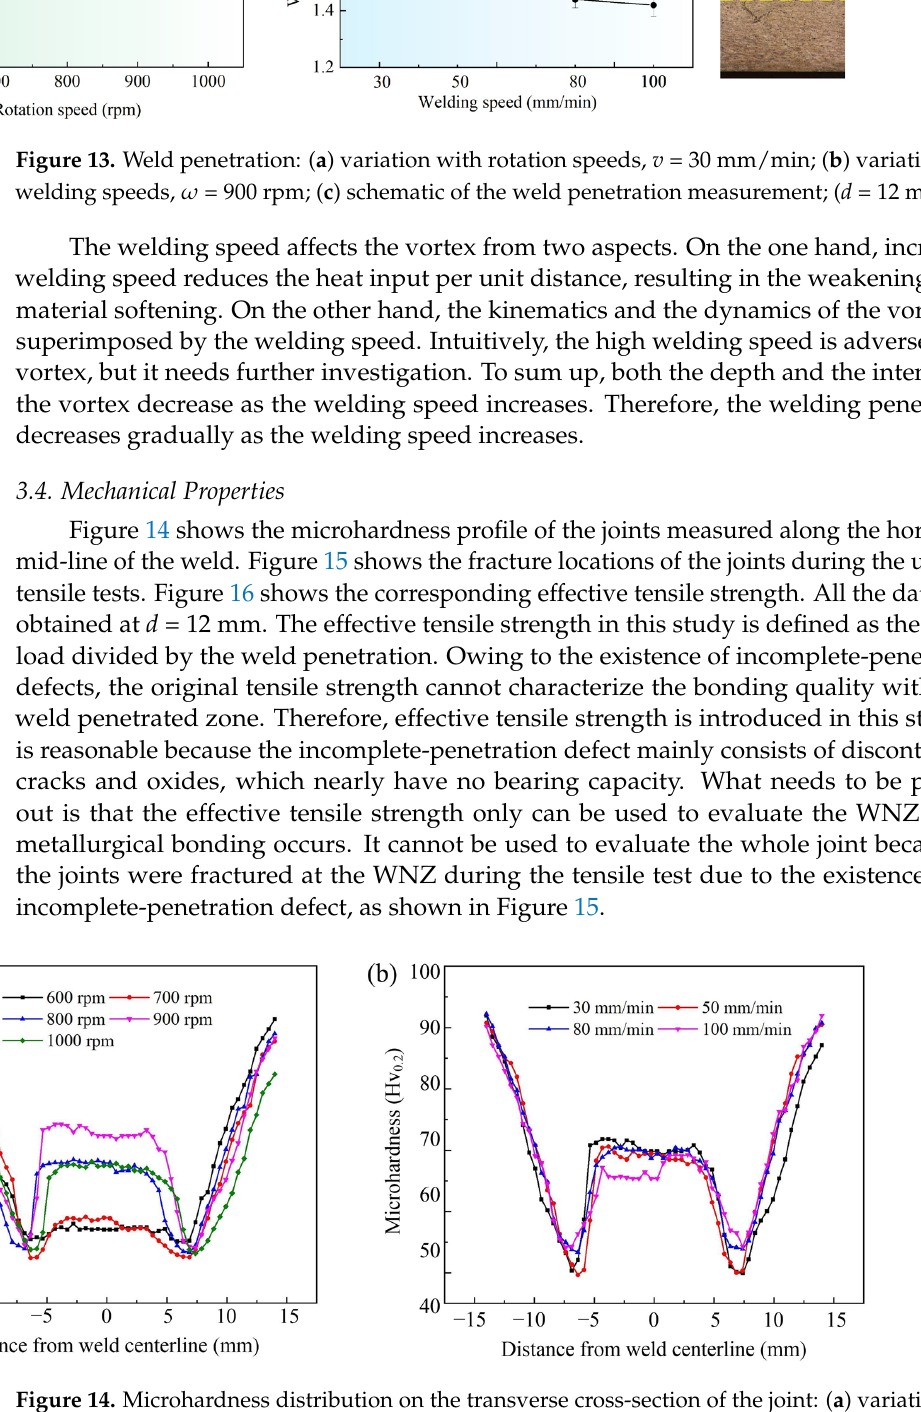
Figure 15. Fracture locations at various rotation speeds and welding speeds: ( a – e ) v = 30 mm/min; ( f – h ) ω = 900 rpm; ( a ) ω = 600 rpm; ( b ) ω = 700 rpm; ( c ) ω = 800 rpm; ( d ) ω = 900 rpm; ( e ) ω = 1000 rpm; ( f ) v = 50 mm/min; ( g ) v = 80 mm/min; ( h ) v = 100 mm/min; ( d = 12 mm).